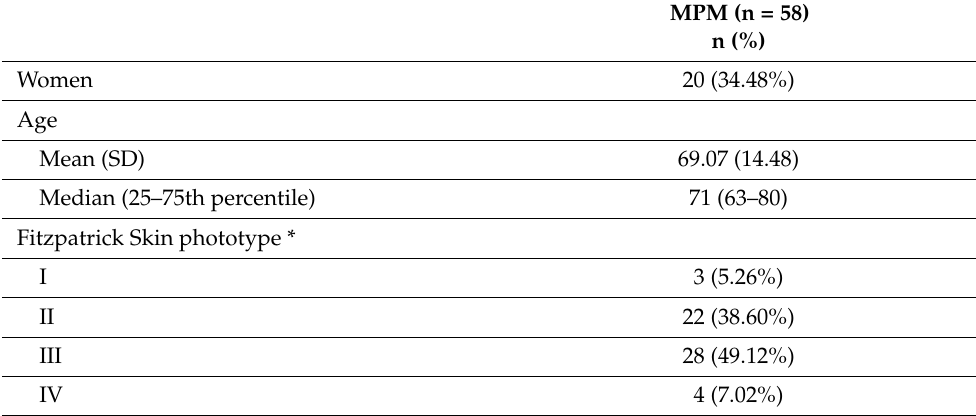
Table 1. Epidemiological and clinical characteristics of patients with multiple primary